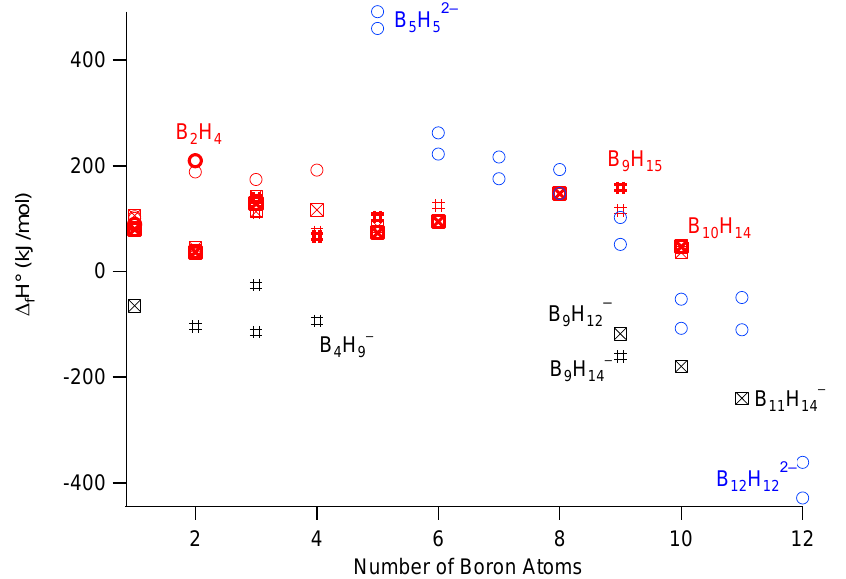
Figure 2. Experimental (bold) and theoretical formation enthalpy values for neutral (red) monoan- ionic (black) and dianionic (blue) species. Closo species, circles; nido, #; arachno, crossed squares. Data from [69 – 72,74 – 76]. For closo ions B n H n2 − , data (blue circles) from 2 different studies [69,72] reveal systematic differences. All monoanionic species (in black) have negative formation enthalpies, while all neutral boranes (in red) have positive formation enthalpy.